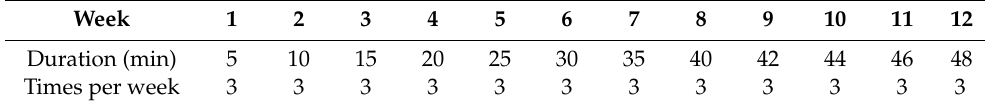
Table 1. The 12 week gait retraining